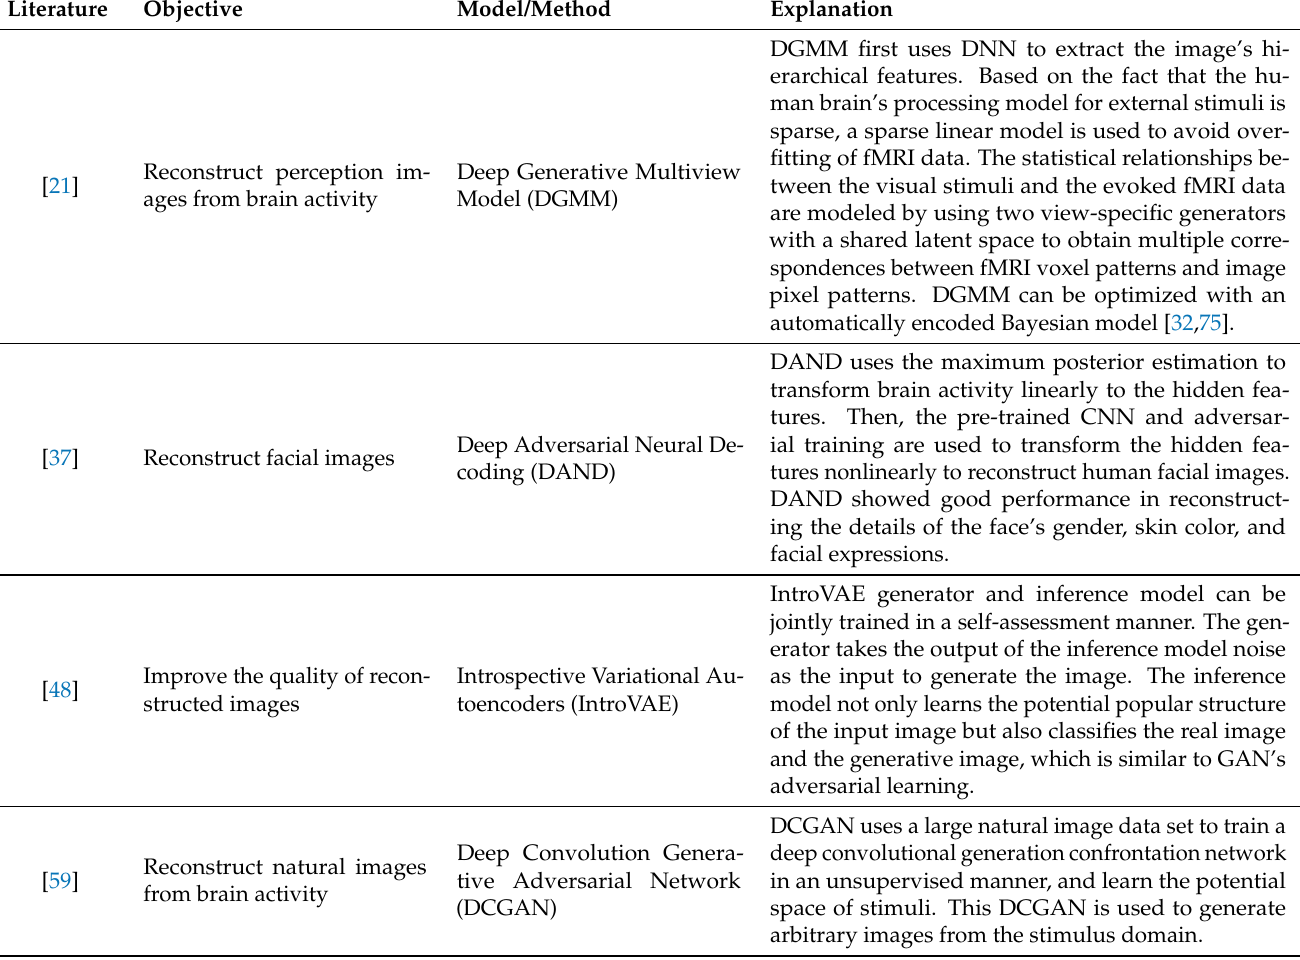
Table 3. Deep generative models based on VAE or